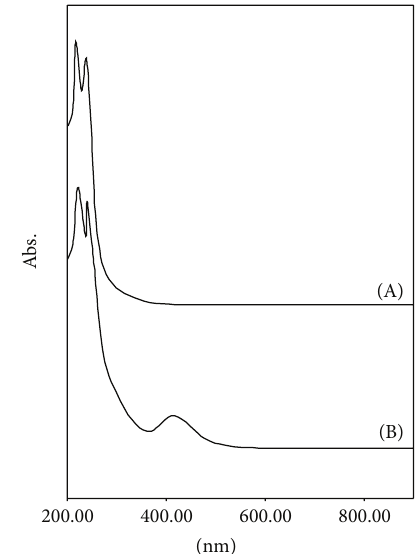
Figure 13: UV-visible spectra of o-phenylenediamine (OPDA) (A) and it analogous polymer (POPDA) (B).